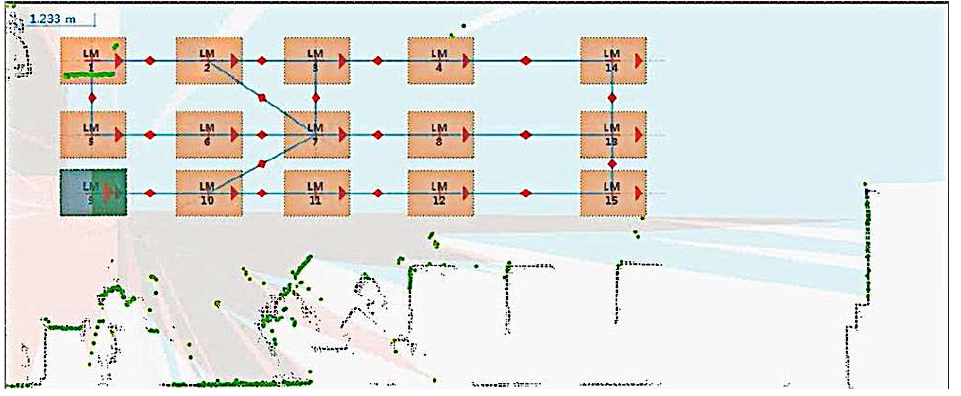
Figure 14. The scene map.